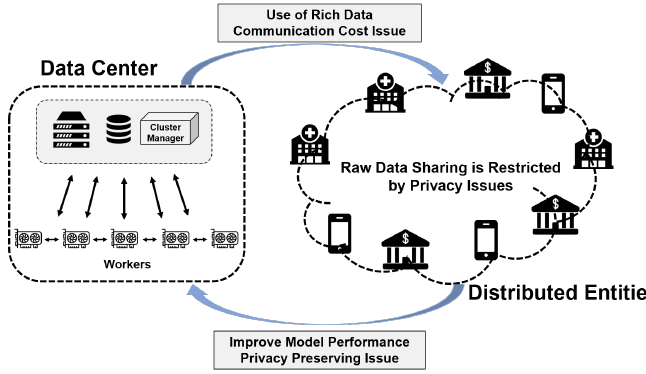
Figure 1. Learning in data centers and distributed domains highlight different aspects of the